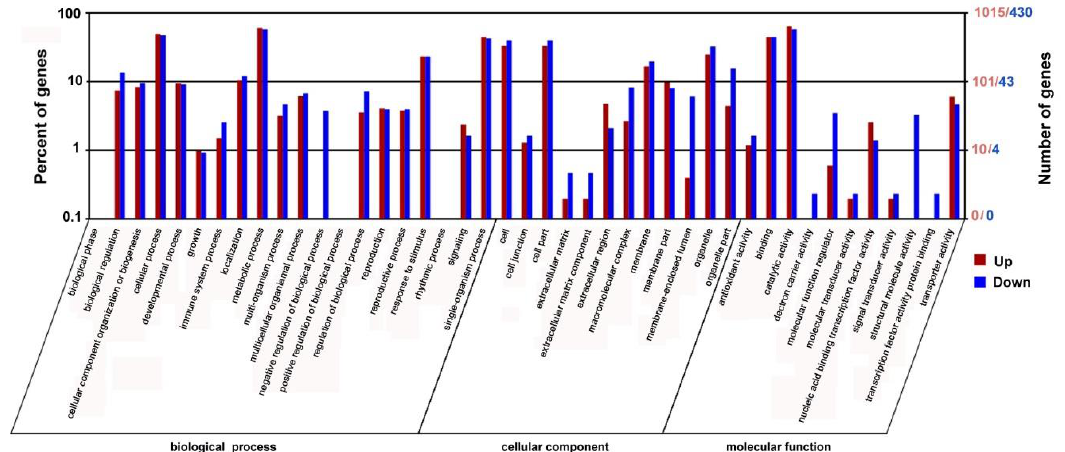
Figure 5. Functional analysis of the DEGs in PtrARF2.1-RNAi and WT plants based on the RNA-Seq data. GO functional enrichment analysis of DEGs between the PtrARF2.1 down-regulated and WT plants based on sequence homology. The top X-axis refers to the number genes annotated by GO term. The bottom X-axis refers to classification of GO including Biological Process, Cellular Component and Molecular Function. The Y-axis represents the percentages of annotated genes accounted for the total annotated genes.The red bar represents upregulated genes and the blue bar represents downregulated genes.